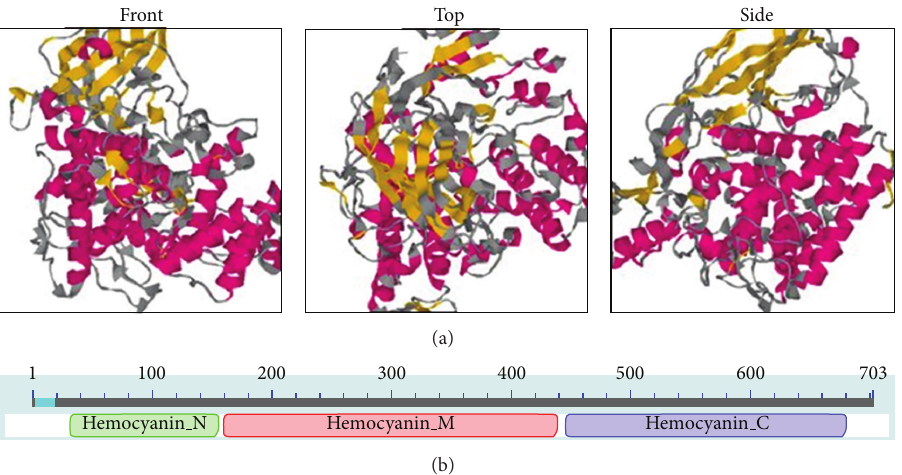
Figure 1: The tertiary structure prediction (a) and three conserved domains (b) of silkworm SP2 protein. (a) Coloring is defined by the dss rasmol script, to show predicted secondary structure (red: helix; yellow: strand; gray: other); (b) Three conservative structural domains of SP2: hemocyanin N domain (amino acids 33–157), hemocyanin M domain (amino acids 161–442), and hemocyanin C domain (amino acids 446–680).